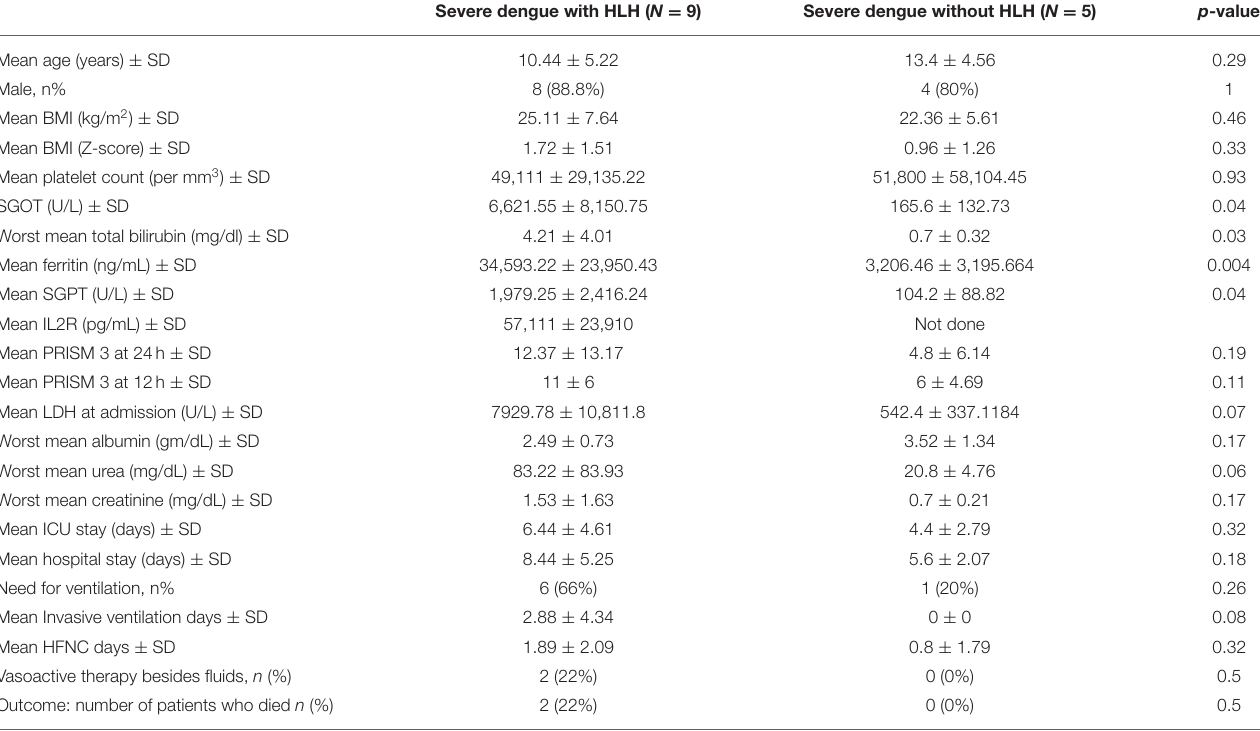
TABLE 1 | Demographic, anthropometric, and laboratory characteristics of patient with severe dengue with and without HLH. Severe dengue with HLH ( N = 9) Severe dengue without HLH ( N =